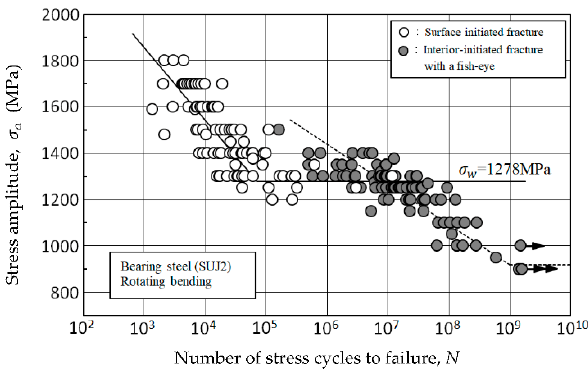
Figure 1. Rotating bending S-N characteristics of bearing steel in very high cycle regime.